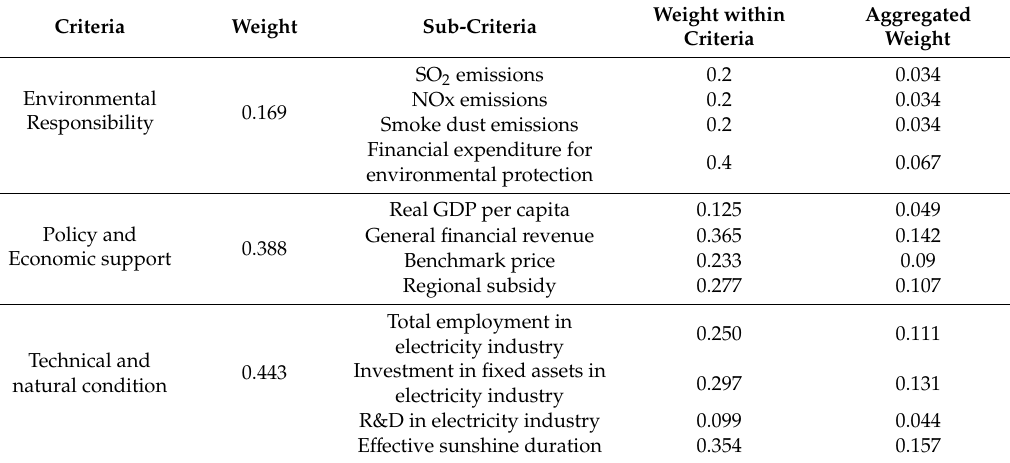
Table A4. The weights of 12 sub-criteria.